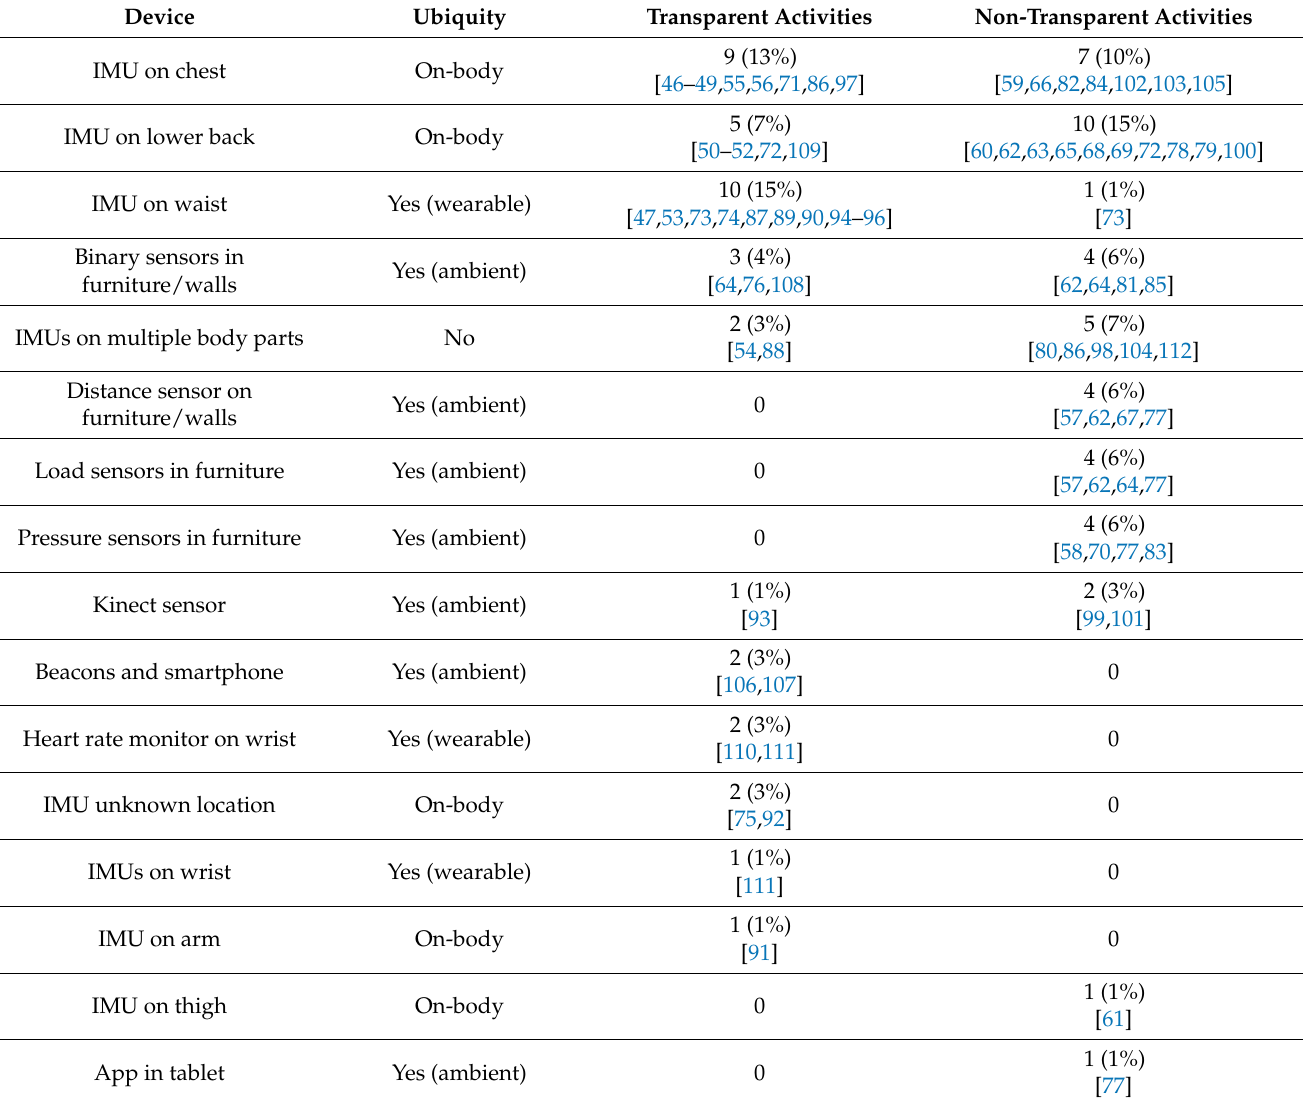
Table 2. Types of devices that have been described in the studies included in the present review (left column) together with their ubiquity level (second column on the left) and the number of Scheme 67 studies in the review. Note that some studies use multiple types of devices; thus, the sum of the percentages in all the different cells does not add up to one hundred.